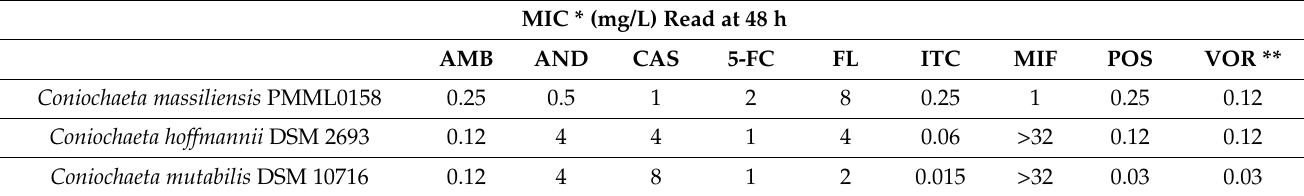
Table 3. Results of in vitro antifungal susceptibility